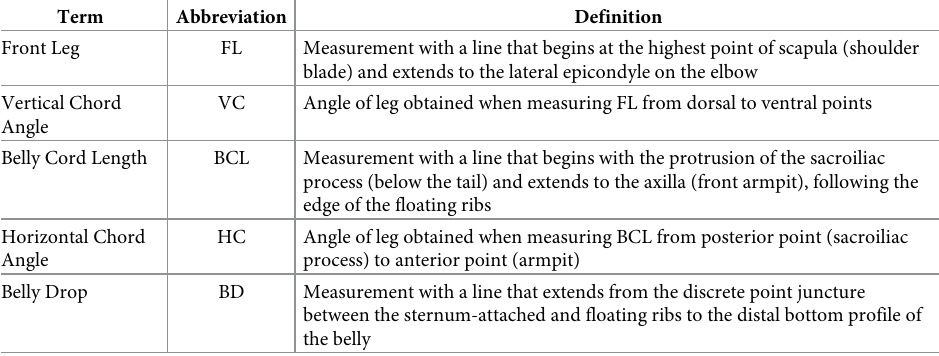
Table 1. Definitions of morphometric terms used to calculate relative belly score for Lycaon pictus .